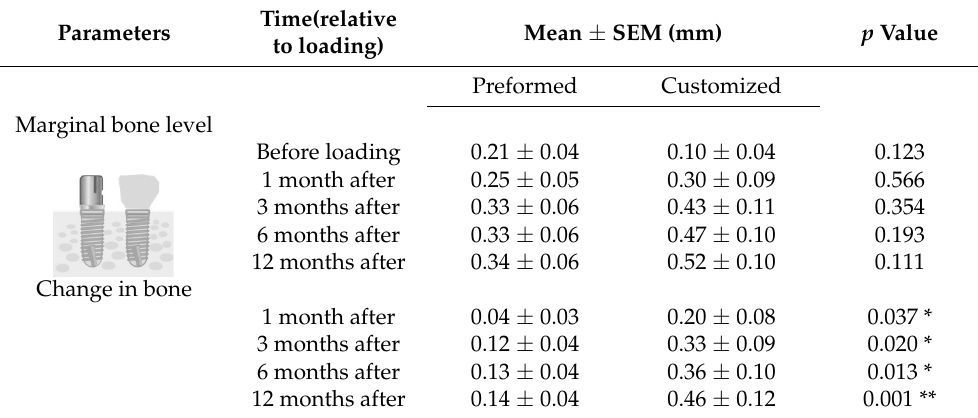
Table 9. Comparison of the average changes in the surrounding implant crestal bone level between the PAs and CAs. CA, customized abutment; PA, preformed stock abutment; SEM, standard error of measurement (* p < 0.05, ** p < 0.01, by two-tailed t -test.).